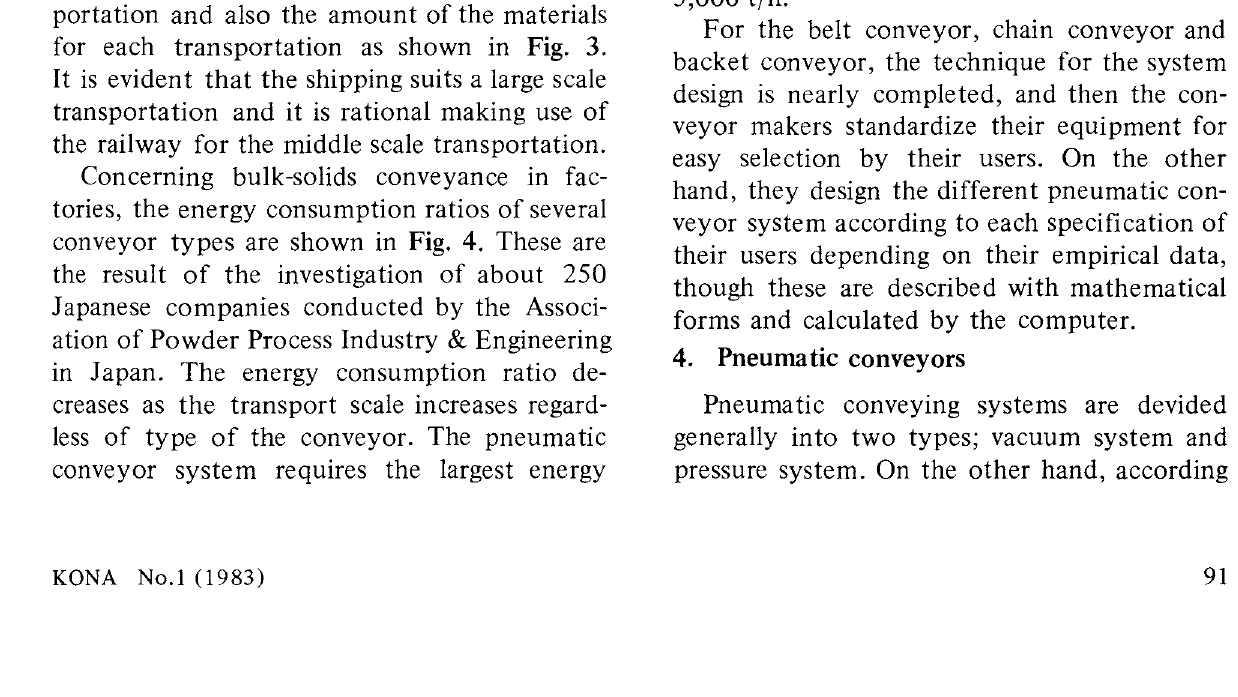
Fig. 4 The relations between the transport scale and the energy consumption ratio of several con veyor types.